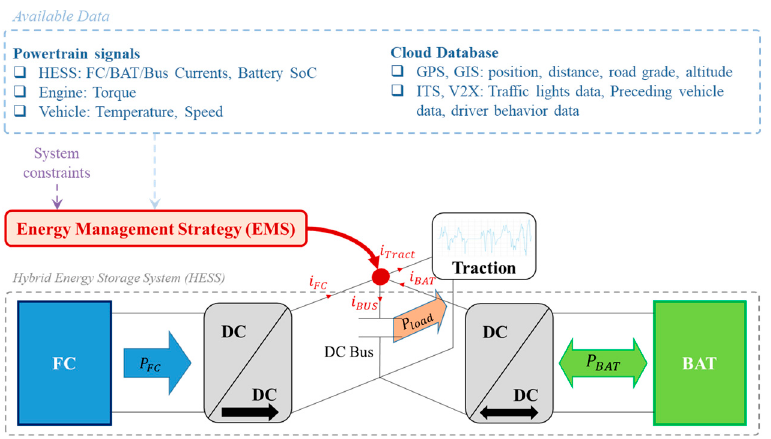
Figure 3. The global architecture of the FCHEV topology. This work has been conducted to easily be reproduced on most FCHEV sizes. There- fore, we designed our system using typical vehicle characteristics according to the result of the sizing methodology proposed in